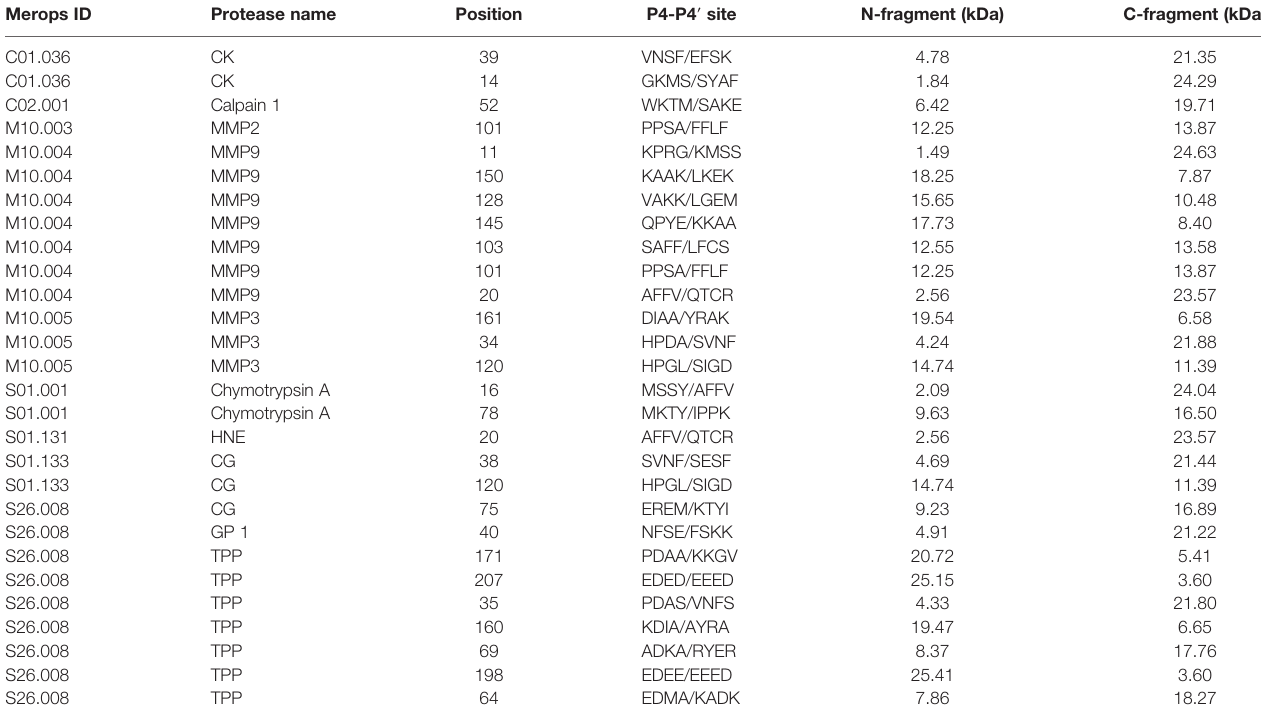
TABLE 1 | Proteases predicted to cleave